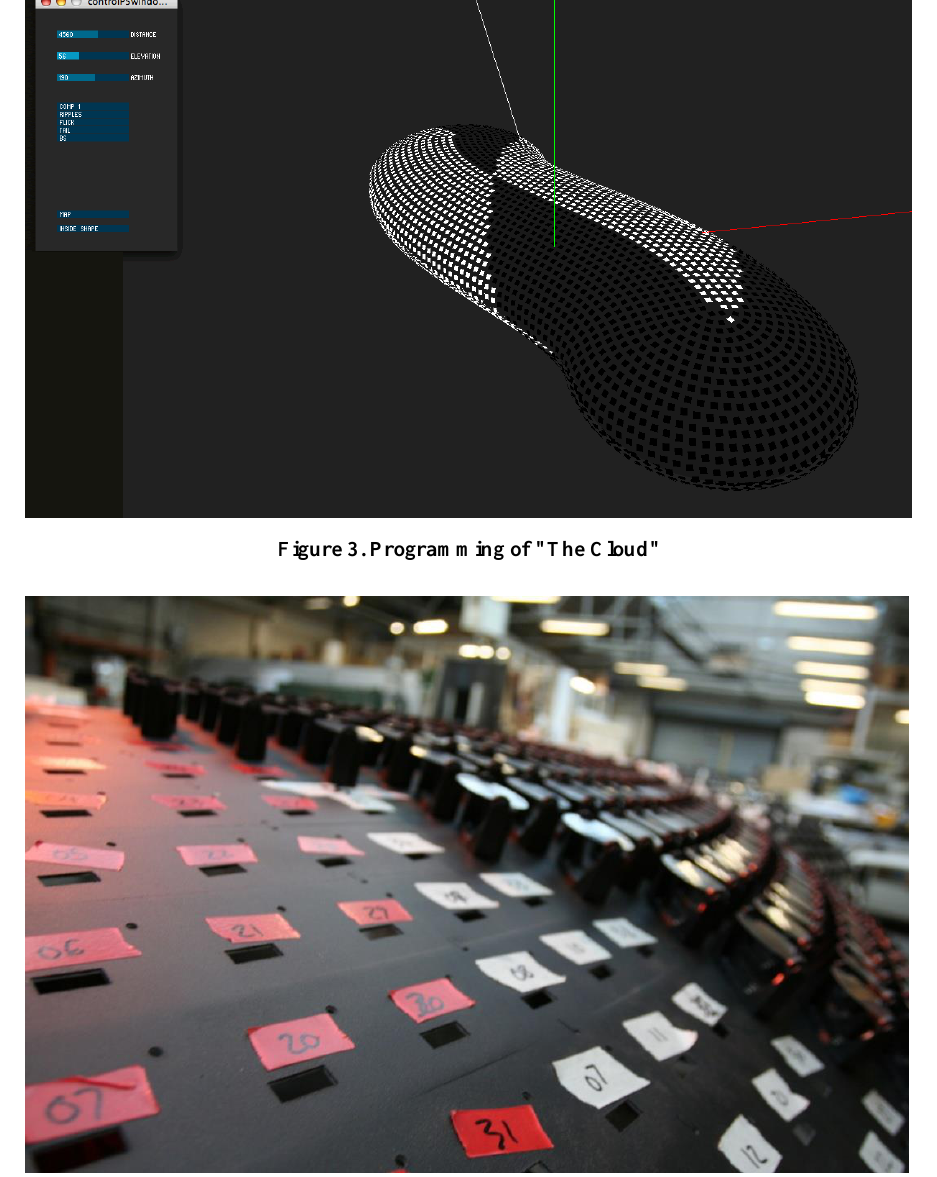
Figure 4. Making of "The